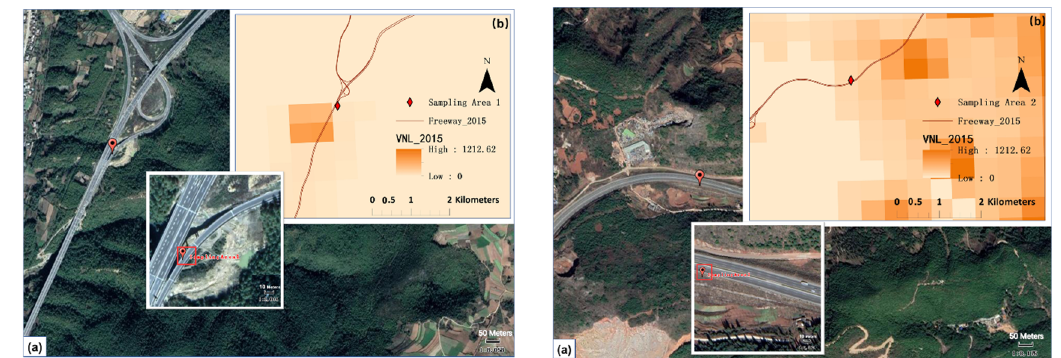
Figure 3. Zoom-in map of the sample area: ( a ) sample area on Google Map; ( b ) corresponding pixel in VNL image.